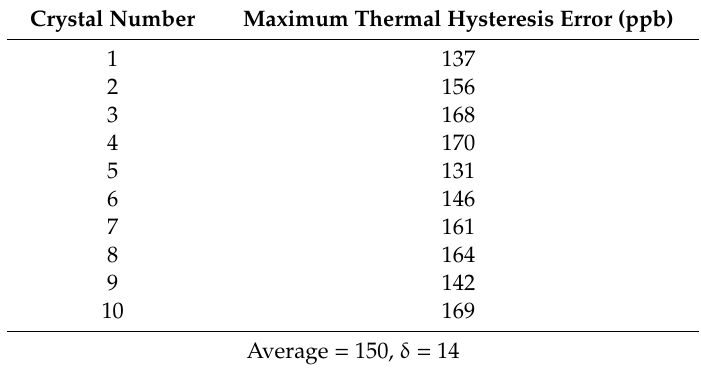
Table 2. Maximum thermal hysteresis error of each TCXO after thermal hysteresis